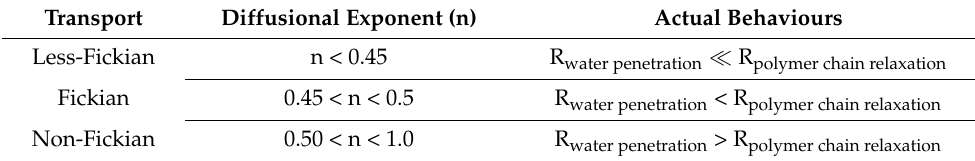
Table 2. Definition of three types of diffusion transport and their corresponding factors. Transport Diffusional Exponent (n) Actual Behaviours Less-Fickian n < 0.45 Fickian 0.45 < n <